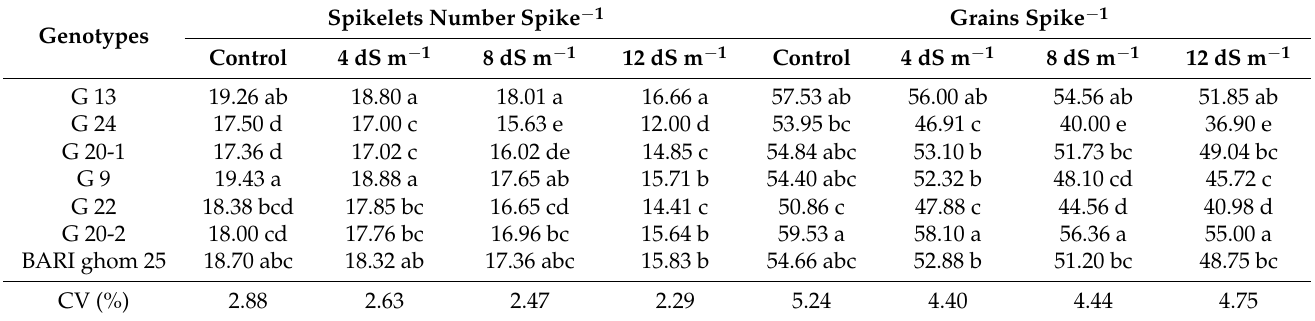
Table 3. Spikelet number spike − 1 and grains per spike of wheat genotypes under different salinity levels.